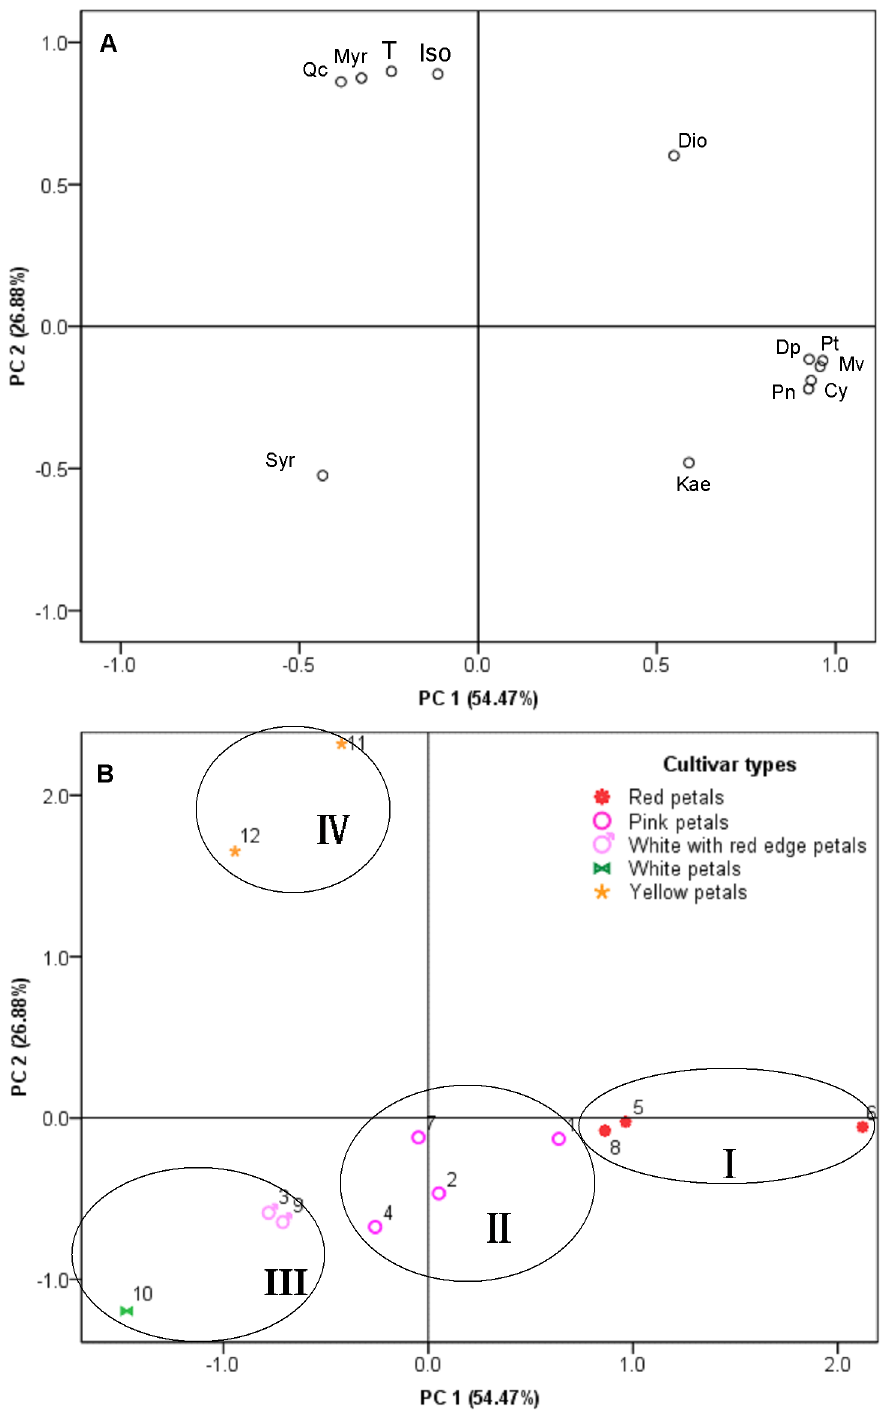
Figure 4. PCA analysis (PC1, PC2) of flavonoids in twelve lotus cultivars based on flavonoid content including anthocyanin and non-anthocyanin flavonoid compounds in flower petals. (A) Score scatter plot; (B) loading plot. Percentages in parentheses represent principal component variance. Numbers in Figure B represent the accession number, corresponding to the numbers in Table 1. Dp=delphinidin 3- O - glucoside; Cy=cyanidin 3- O -glucoside; Pt=petunidin 3- O -glucoside; Pn=peonidin 3- O -glucoside; Mv=malvidin 3- O -glucoside; Myr=myricetin derivatives; Qc=quercetin derivatives; Kae=kaempferol derivatives; Iso=isorhamnetin derivatives; Syr=syringetin 3- O -glucoside; Dio=diosmetin derivatives T=total flavonoid contents.